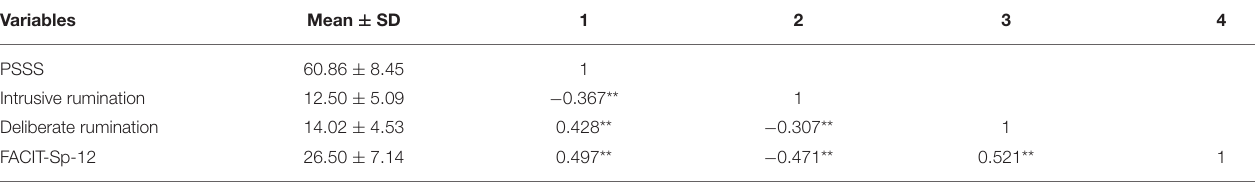
TABLE 2 | Relationships between perceived social support, rumination, and spiritual well-being.